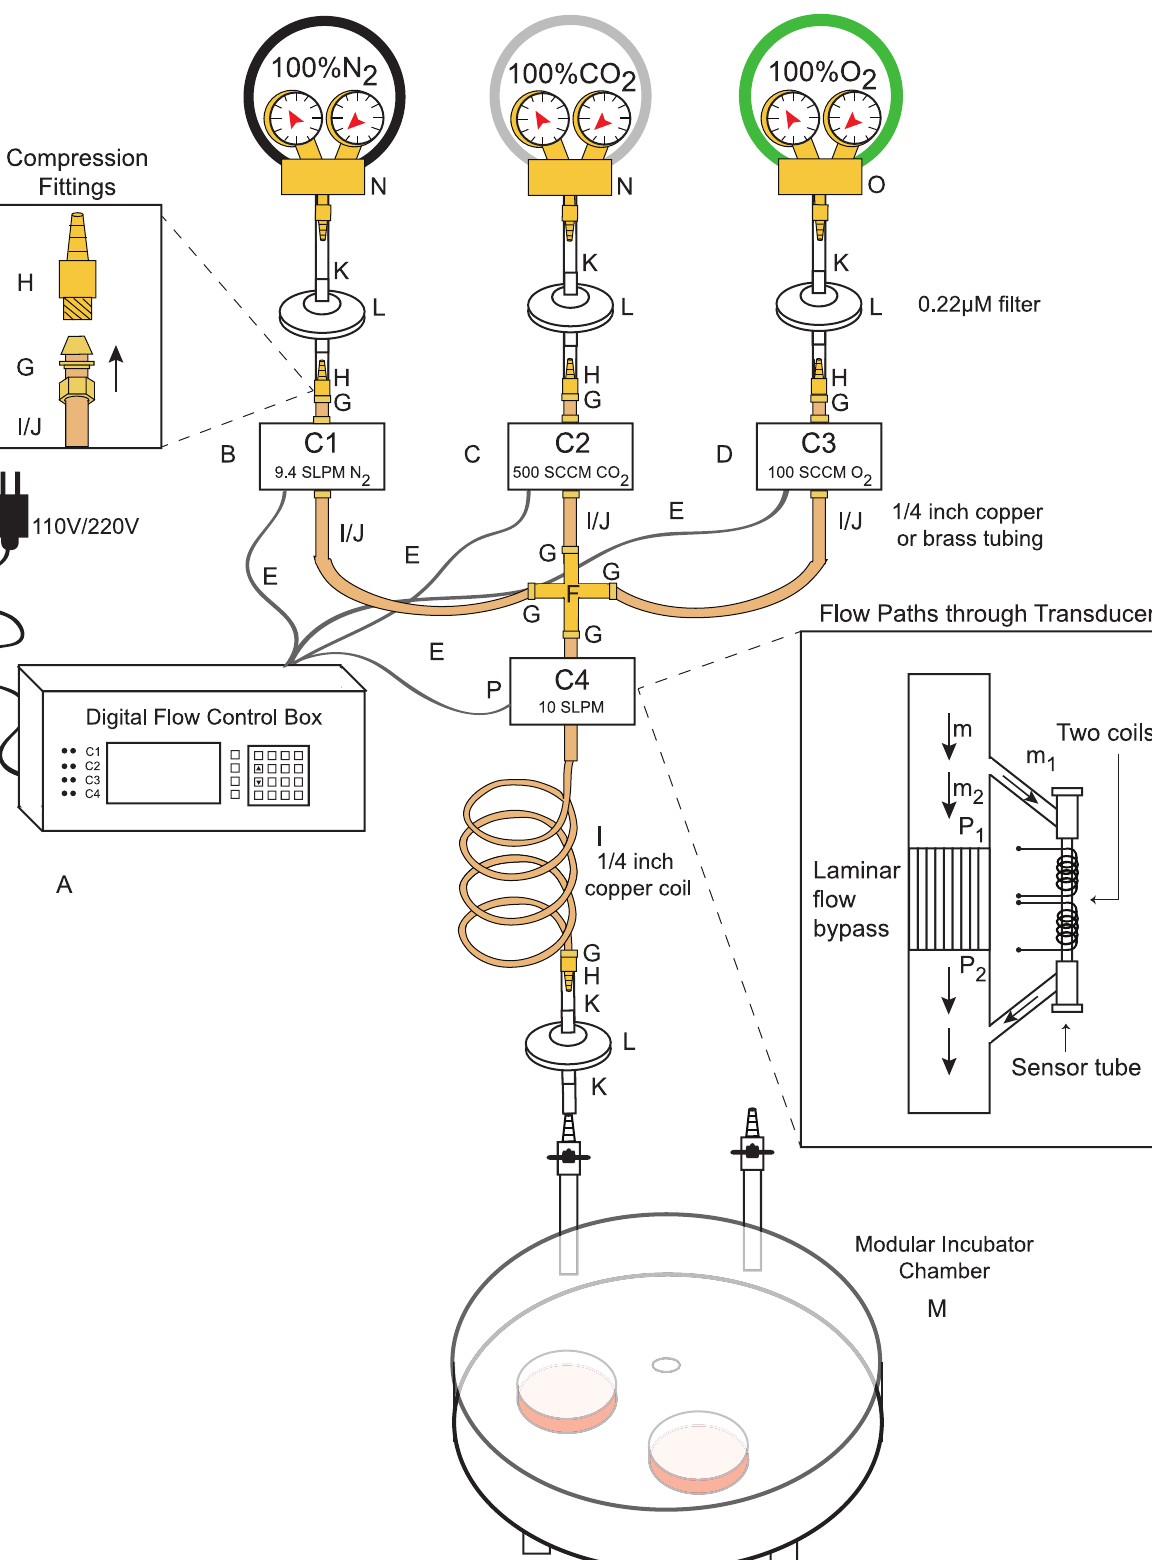
PLOS ONE | www.plosone.org